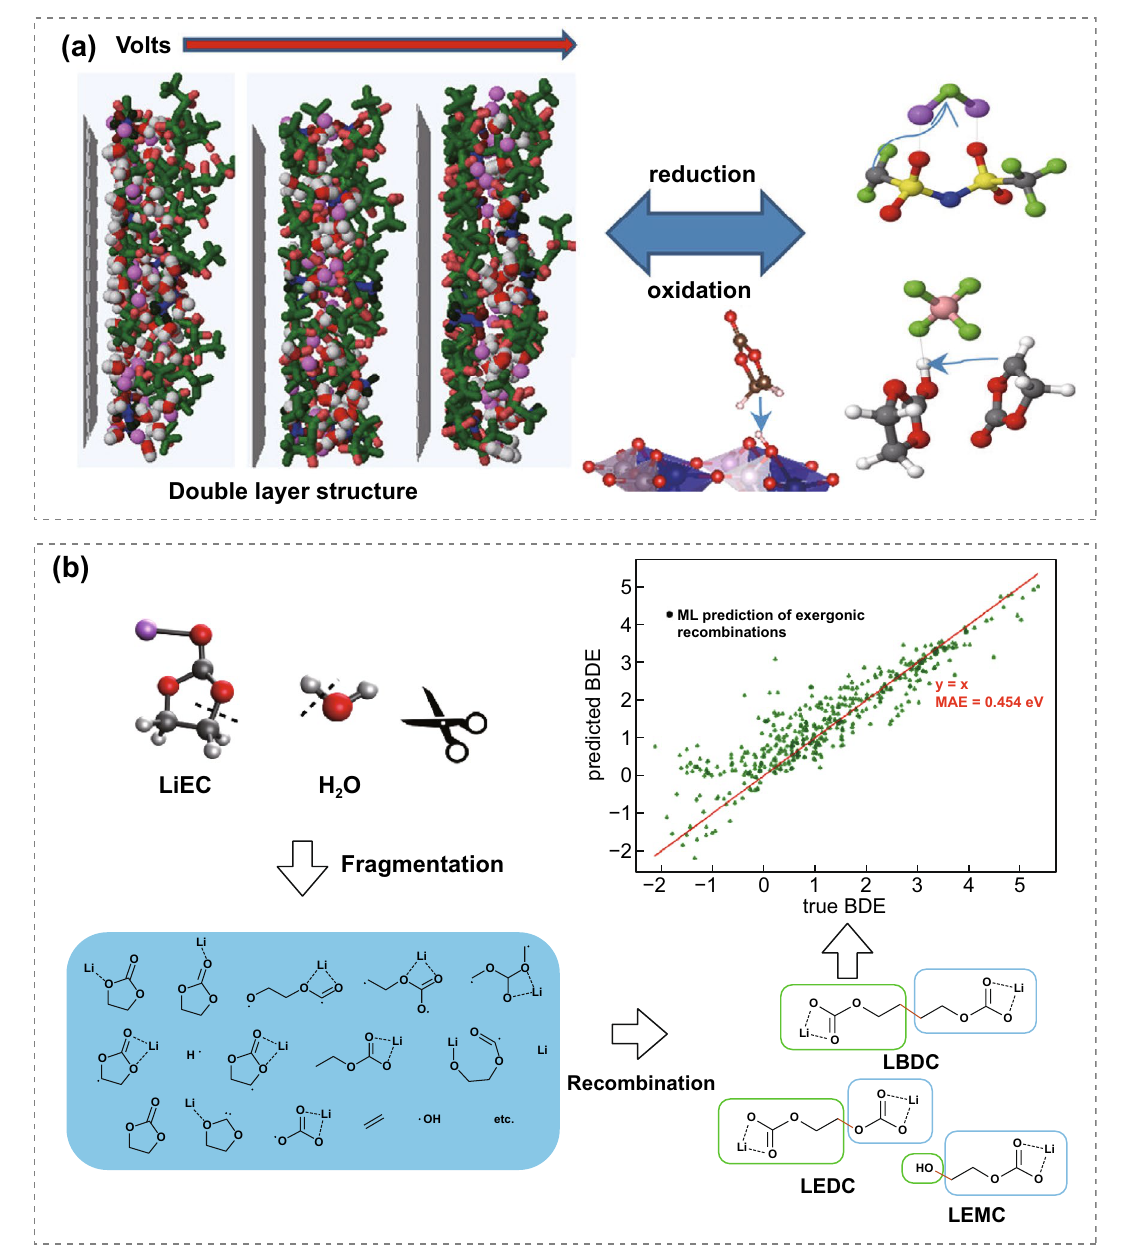
Fig. 4 a Snapshots on the interfacial structure from MD simulations of (Dimethyl carbonate) 1.2 LiTFSI and preferential decomposition. Copy- right from Ref. [45]. b Data-driven machine learning workflow for generating relevant molecules. Copyright from Ref.